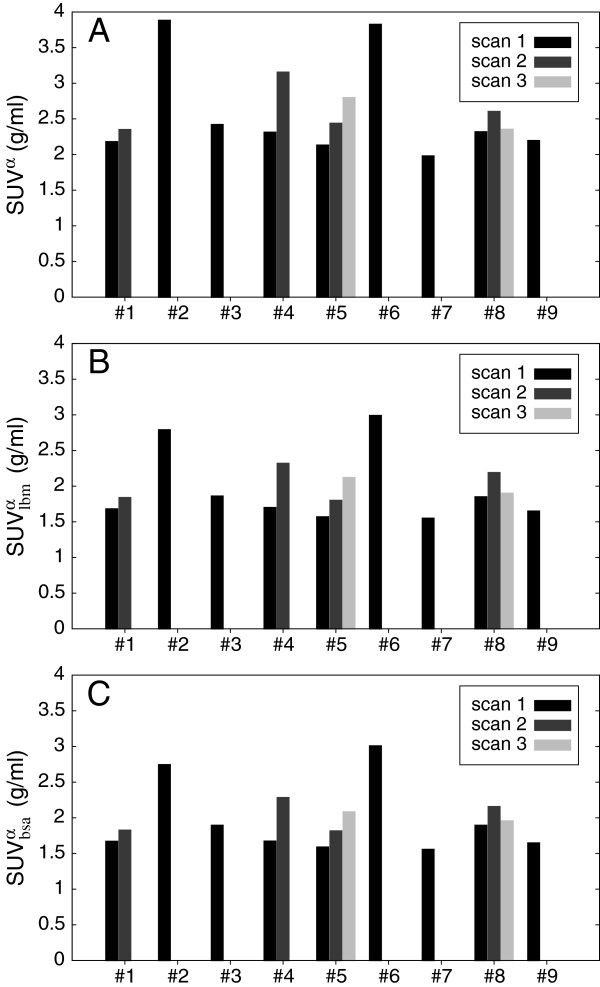
Inter-study variability of ca (55 min p.i.) in nine subjects and 15 scans expressed in three SUV units.(A) Conventional SUV (body weight normalized), (B) SUVlbm (lean body mass normalized), and (C) SUVbsa (body surface area normalized).